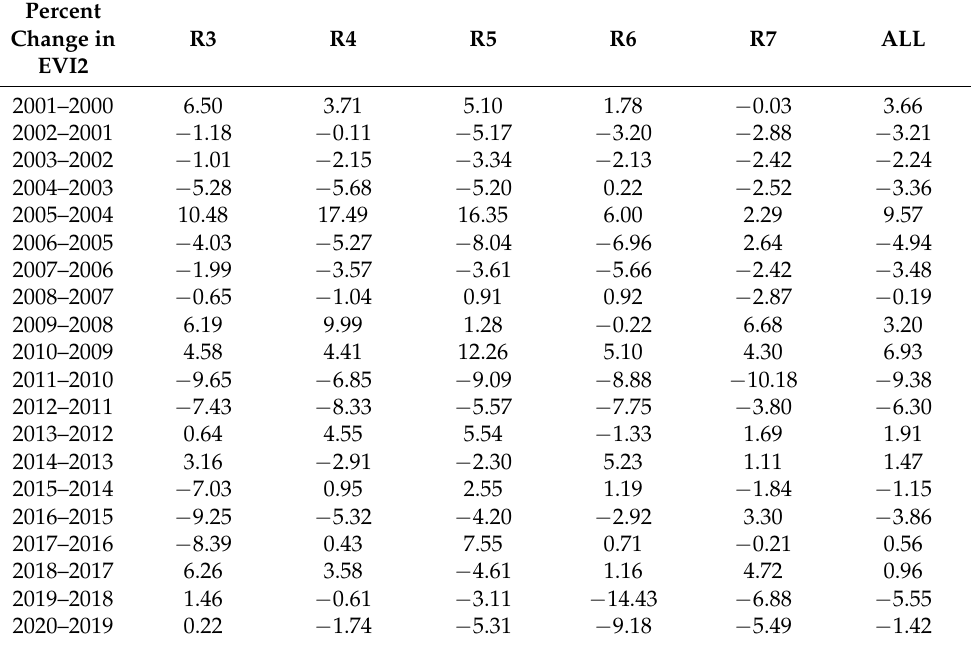
Table A3. Landsat EVI2 percent change in the riparian vegetation greenness in the Lower Colorado River from year-to-year using average growing season dates from 1 May to October 30.